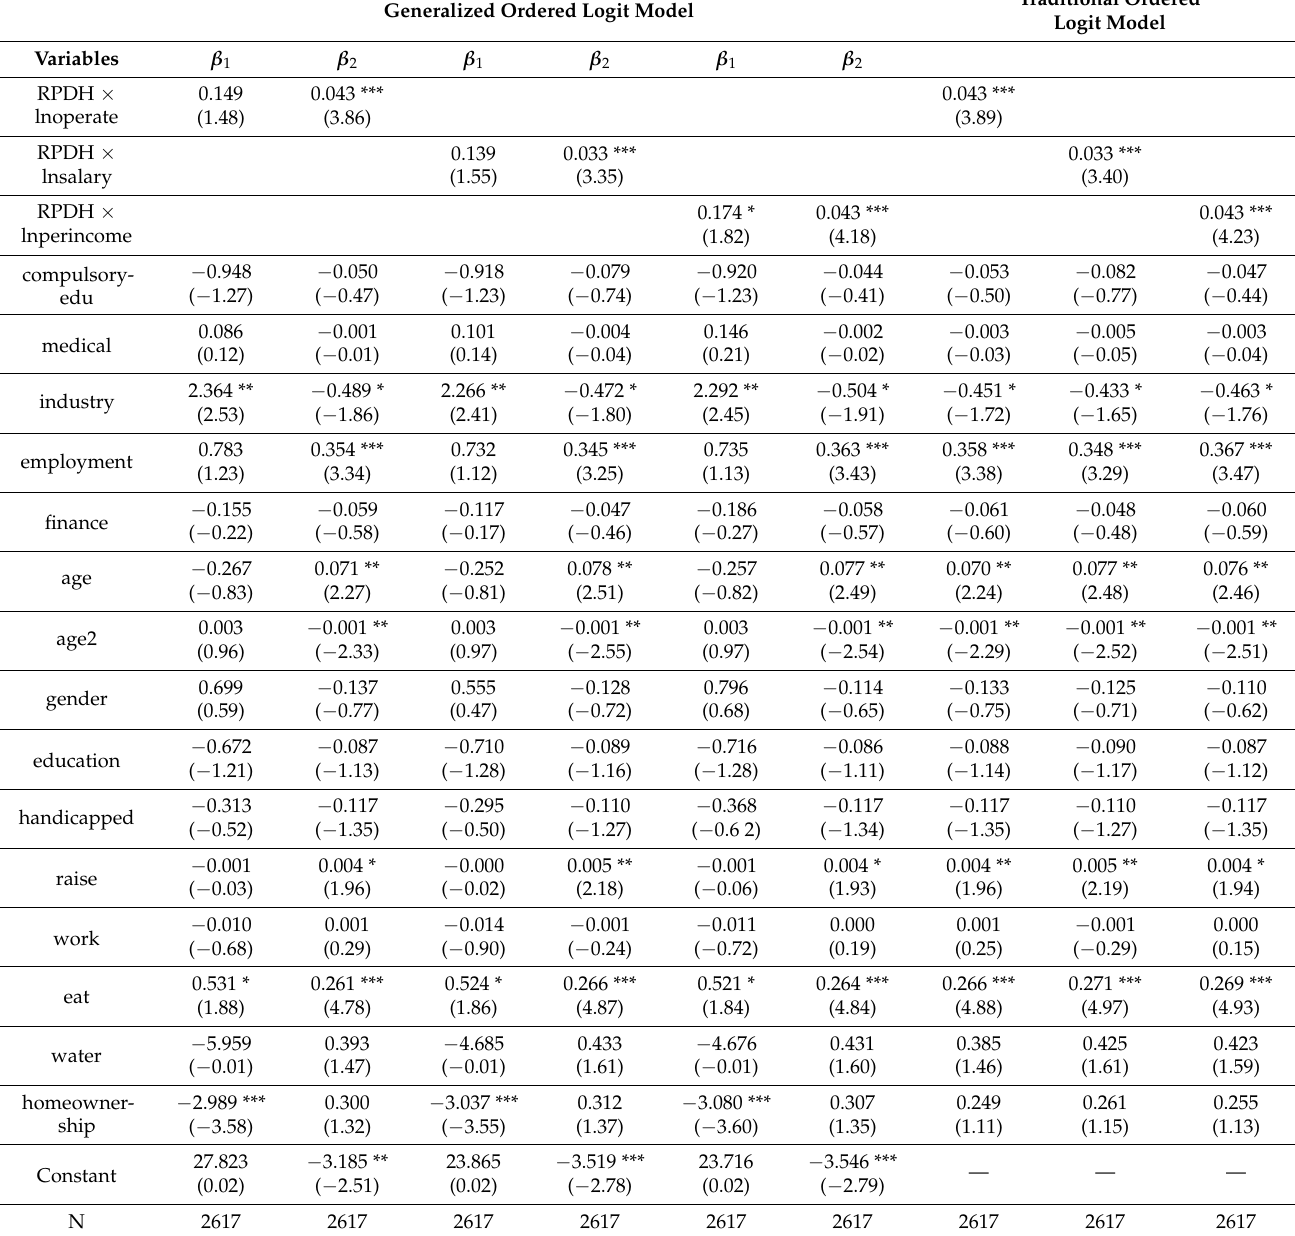
Table 11. Regression results of